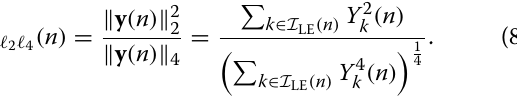
Y k ( n ) , k = 1, . . . , N / 2 − 1 for frame n are sorted in